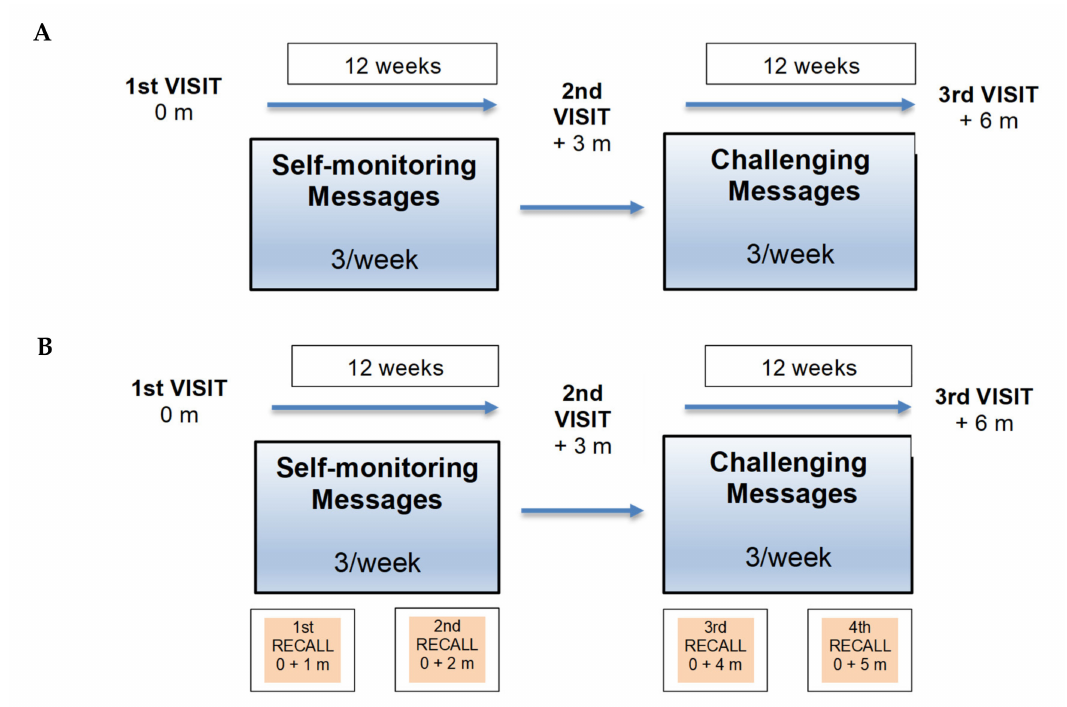
Figure 1. (Panel ( A )) Intervention Group PediaFit 1.1 with three regular visits (VISITS) and three weekly messages. (Panel ( B )) Intervention Group PediaFit 1.2 with three regular visits, three weekly messages, and four on site recall visits (RECALLS) for a total of 7 in presence contacts. (m =